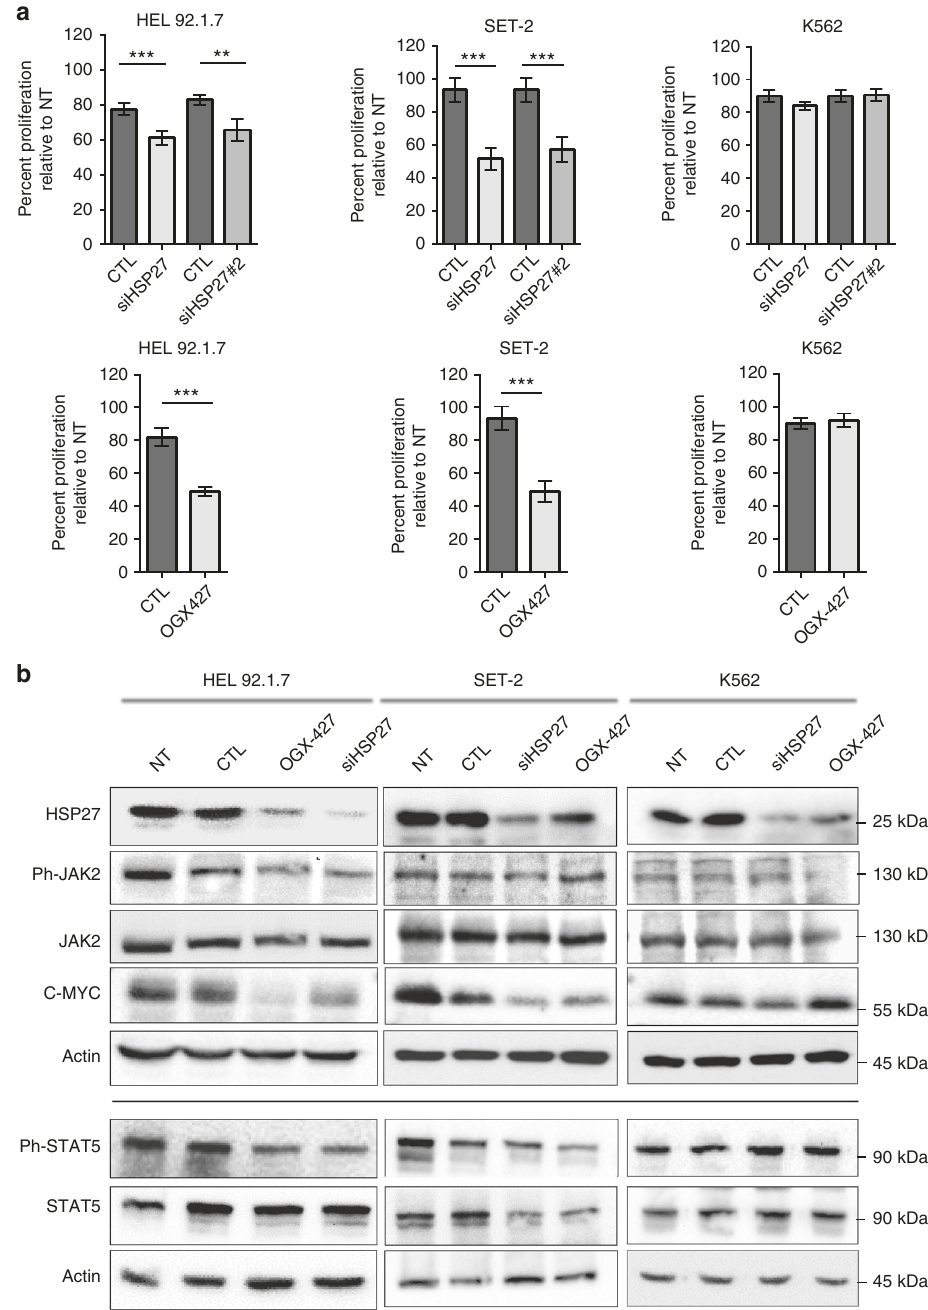
Fig. 3 HSP27 affects proliferation of JAK2V617F leukaemic cell lines. a HEL92.1.7, SET-2 and K562 cells were transfected with HSP27 siRNA, OGX-427 or an oligonucleotide control (CTL). Bars represent cell proliferation percentages relative to non-transfected cells (NT) from 9 independent experiments. P values were calculated using the Mann – Whitney test. ** P < .01. Error bars represent ±s.e.m. b HEL92.1.7, SET-2 and K562 cells were transfected with HSP27 siRNA, OGX-427 or CTL and lysed 48 h later in Laemmli Buffer. Protein expression was determined by western blot and compared to non- transfected cells (NT). Actin was used as the loading control ( n = 3 independent experiments). See quanti fi cation of the blot in Supplementary Fig.